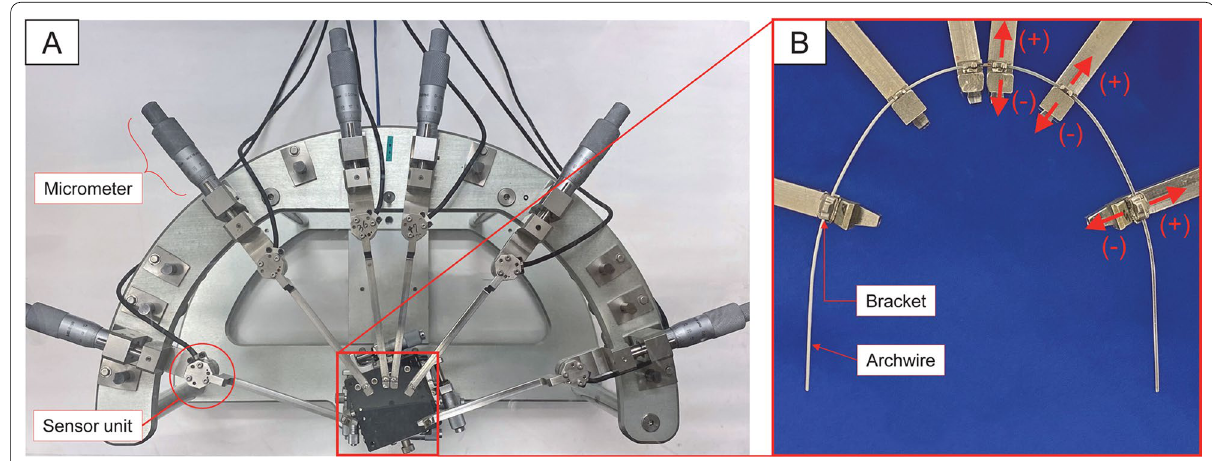
Fig. 3 The multi-sensor measurement system. A Overview of the multi-sensor measurement system. B Close-up view of the stainless steel blocks that simulated the position of the central incisors, canines, and first molars aligned to the dental arch form of normal occlusion. Brackets were placed at the center of the facial surface of each tooth. The orthodontic force in the facial-lingual direction was measured along the perpendicular axis of the center of the bracket slots. When the detected orthodontic force was delivered in the facial direction, a positive value was